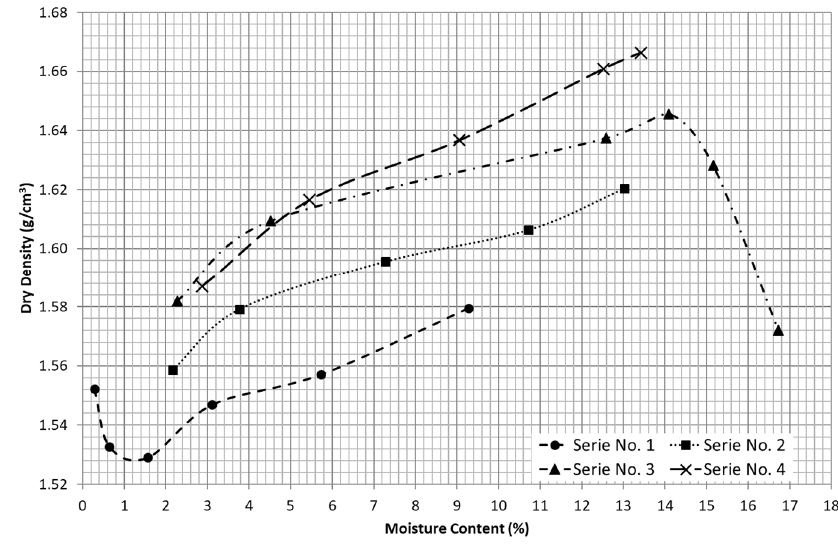
Figure 3. Compaction curves for each series tested.